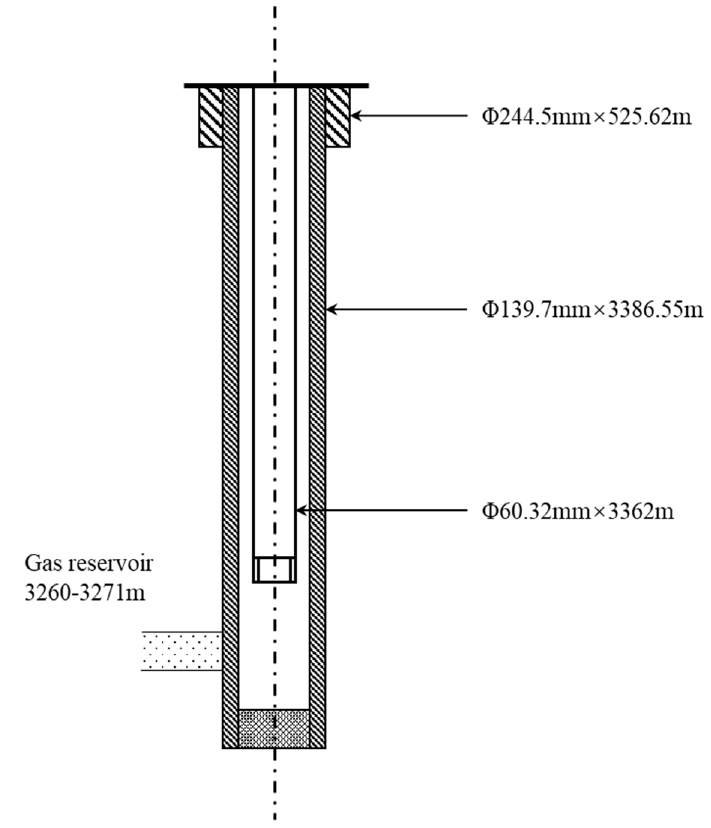
Figure 3. Wellbore configuration chart.